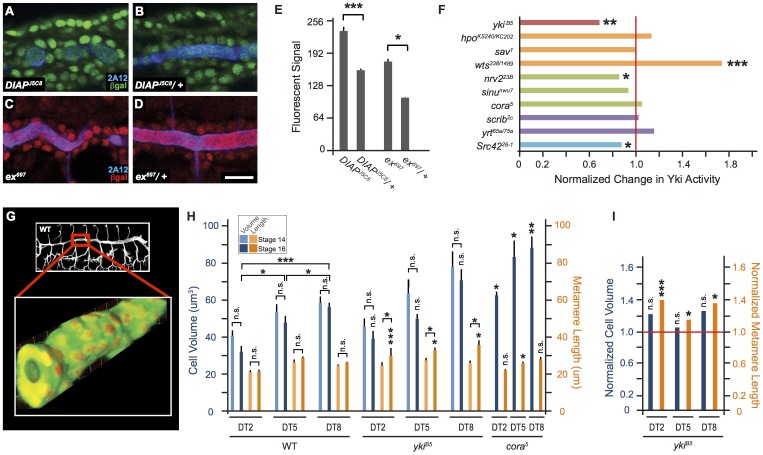
Tracheal Length Changes are Correlated with Yki Activity, but Not with Tracheal Cell Size.(A–F) Quantification of Yki reporter activity in WT and tracheal mutant backgrounds. Embryos homozygous for DIAP-lacZ reporter (A, green) or ex-lacZ (C, red) have approximately twice the signal (E) of nuclear β-gal staining in tracheal cells compared to embryos heterozygous for these reporters (B,D). (F) yki mutant embryos show strongly reduced reporter activity, while wts mutant embryos have dramatically increased reporter activity. Mutations in SJ and basolateral polarity pathways do not consistently or strongly affect reporter activity. Measurements for yki, hpo, nrv2, cora, and Src42 used ex-lacZ, while sav, wts, sinu, scrib, and yrt used DIAP-lacZ. Normalized values are shown as the fold-change of the signal in trachea homozygous for a mutation compared to heterozygous control trachea on the same slide. Scale bar for (A–D) in (D), 10 µm. (G–I) Tracheal segment length is not correlated with cell volume. Cell volumes were measured in embryos expressing a cytoplasmic and nuclear GFP [48]. Embryos were fixed [8], stained for GFP to visualize tracheal cell bodies and nuclei (G, green) and for Trachealess to visualize nuclei [51]. Cell numbers, volumes, and segment lengths were analyzed using Volocity software (materials and methods). (H) Quantification of average tracheal cell volume (in light and dark blue) and metamere length (in light and dark orange) for segments 2, 5, and 8 at stages 14 (light blue and light orange) and 16 (dark blue and dark orange) for both WT and ykiB5. Average cell volume and metamere length were also determined for cora5 at stage 16. Notably, cell volumes consistently decrease (but are not statistically significant) between stages 14 and 16, whereas segment length increases. Statistics shown for ykiB5 and cora5 are comparisons to WT. (I) Quantification of ykiB5 cell volumes and segment lengths at stage 16 normalized to WT measurements. ykiB5 mutant trachea are longer (orange) than WT, but cell volumes (blue) are not statistically significant different than WT. Legend in (H) also applies to (I). *, p<0.05; **, p<0.005; ***, p<0.0005; n.s., not statistically significant; p-values determined using Student's t-test. Error bars show s.e.m.